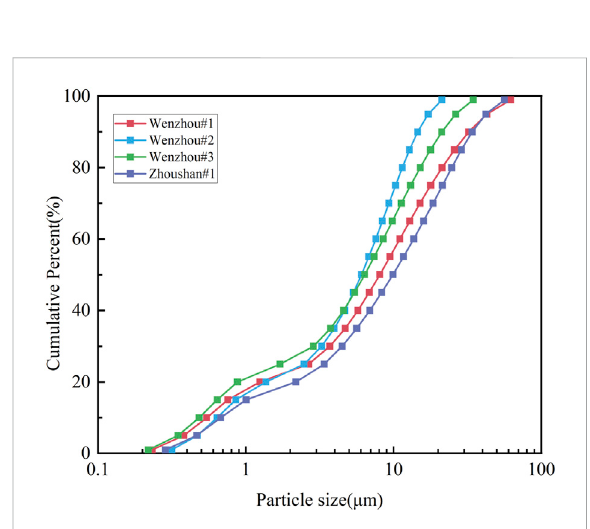
FIGURE 2 Particle distribution of the collected natural mud